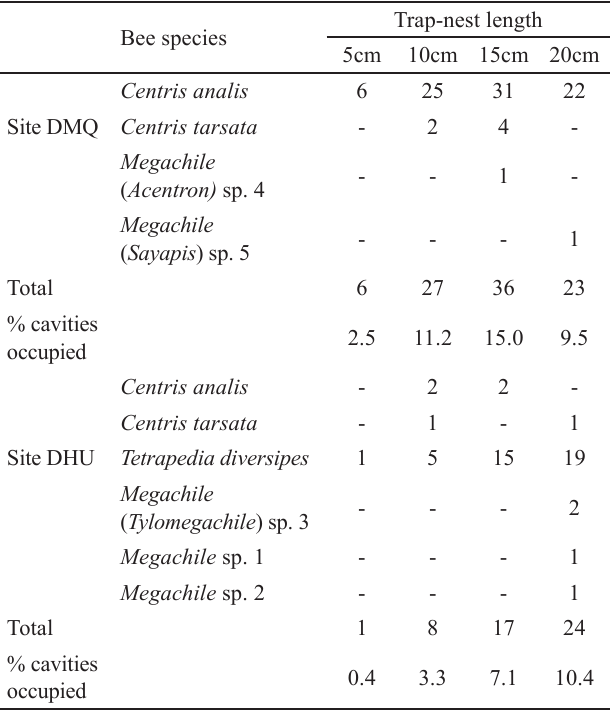
Table 1 . Number of nests established by solitary bees in trap-nests